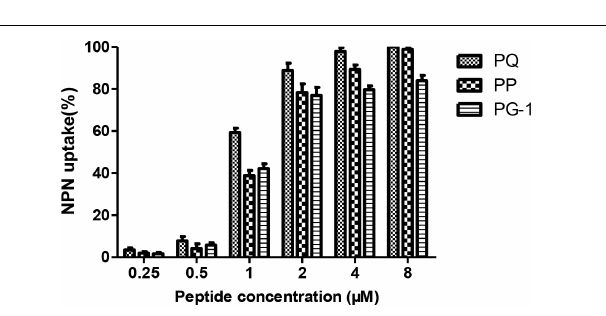
FIGURE 6 | Outer membrane permeabilization assays of PQ, PP and PG-1.